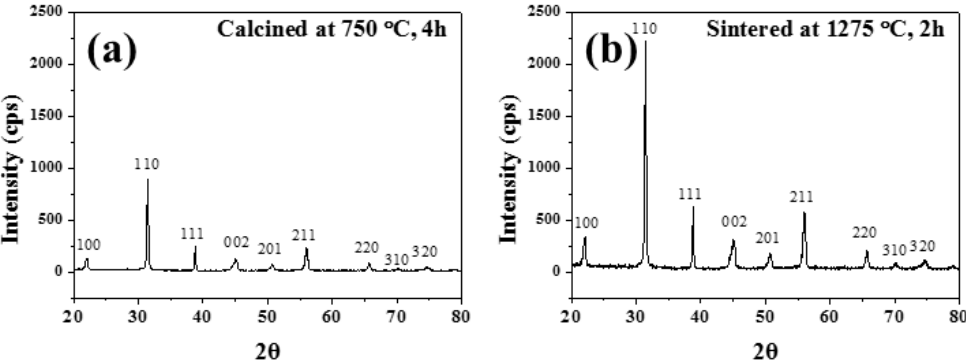
Figure 2. X-ray diffraction patterns for the 0.675PbMgNbO 3 -0.325PbTiO 3 powders after calcination ( a ) and after sintering ( b ).